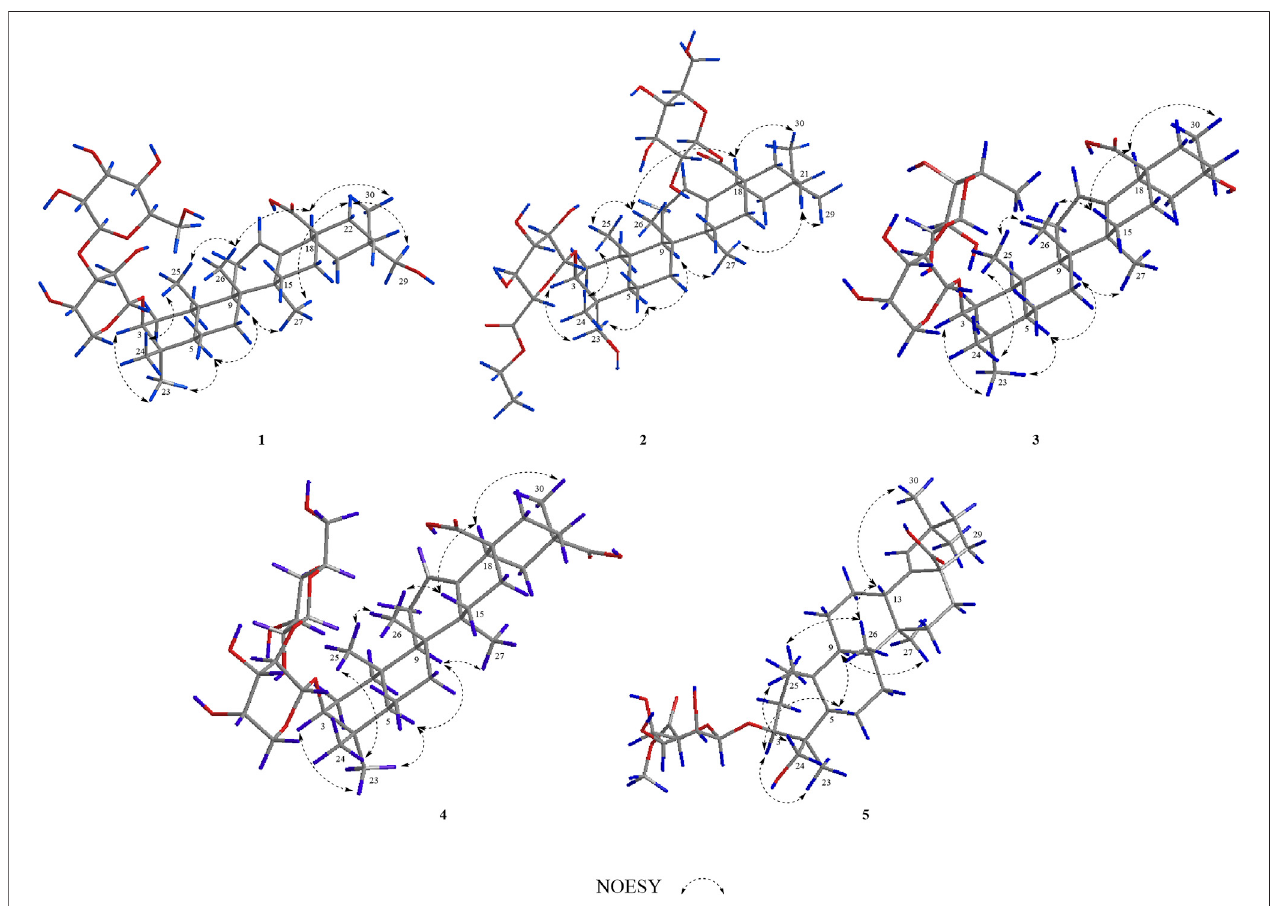
FIGURE 3 | Key NOESY correlations of compounds 1 – 5